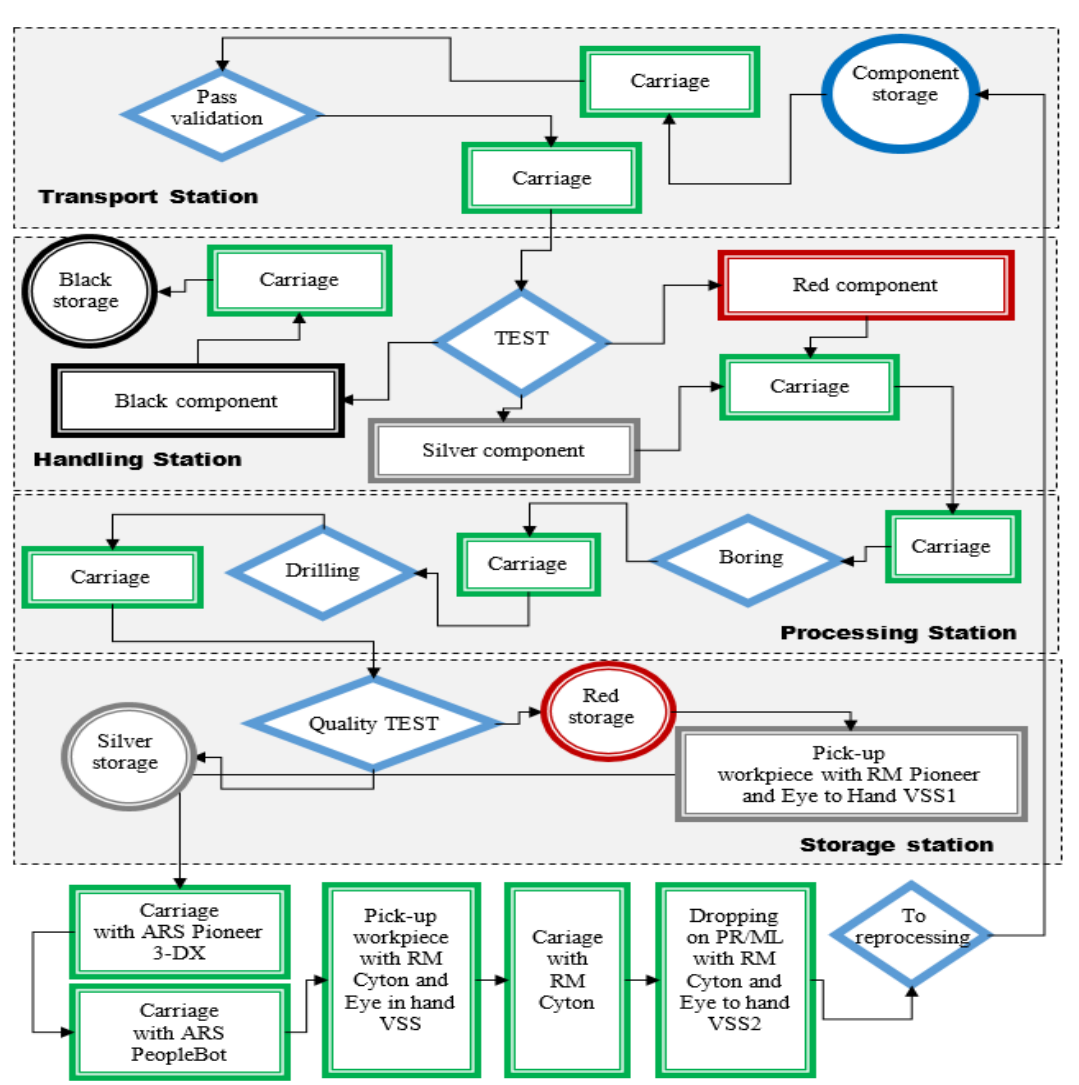
Figure 4. P/R cycle: transport, handling, drilling, boring, storage, pick-up, dropping. Figure 4. P / R cycle: transport, handling, drilling, boring, storage, pick-up,